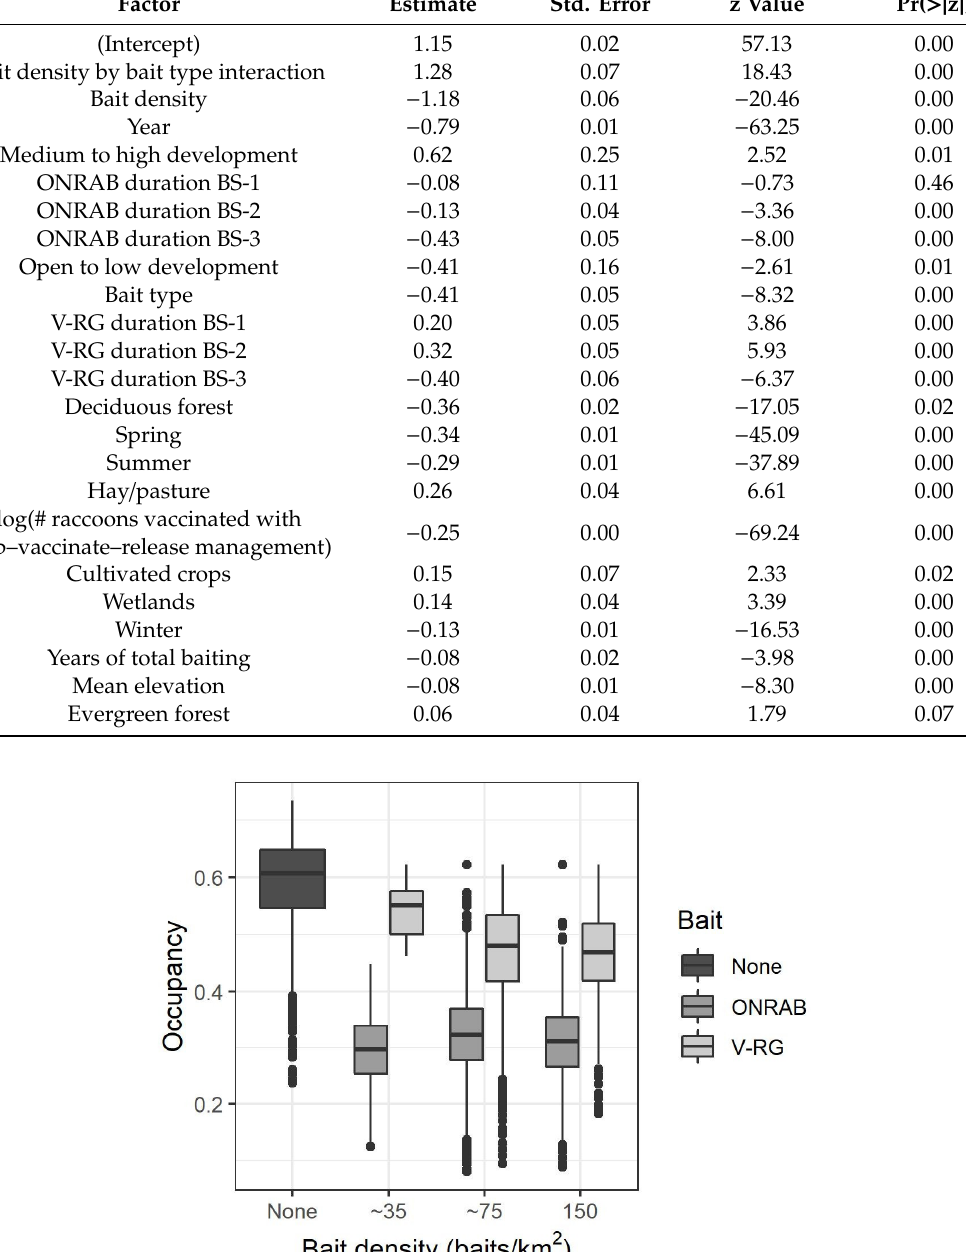
Table 1. Covariate estimates for the beta regression model on RABV occupancy. Factors are sorted in descending order from the absolute magnitude of the effect. The duration of baiting by V‐RG and Ontario Rabies Vaccine Bait (ONRAB) were modeled with basis functions (BS) to allow for non‐linear effects. Their factors are grouped together and sorted based on the largest magnitude effect. Factor Estimate Std. Error Factor Std. Error − 1.18